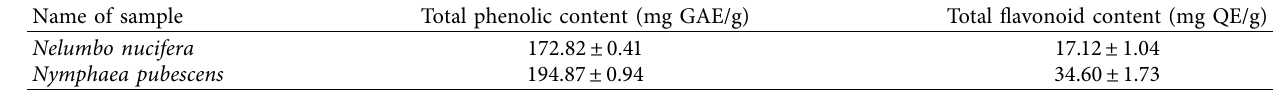
Table 1: Total phenolic and flavonoid contents of N. nucifera and N. pubescens .